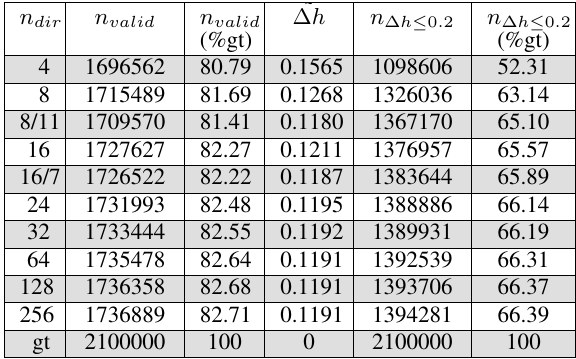
Table 2. Coverage and accuracy for a scene subset with detailed objects processed with different numbers of SGM path